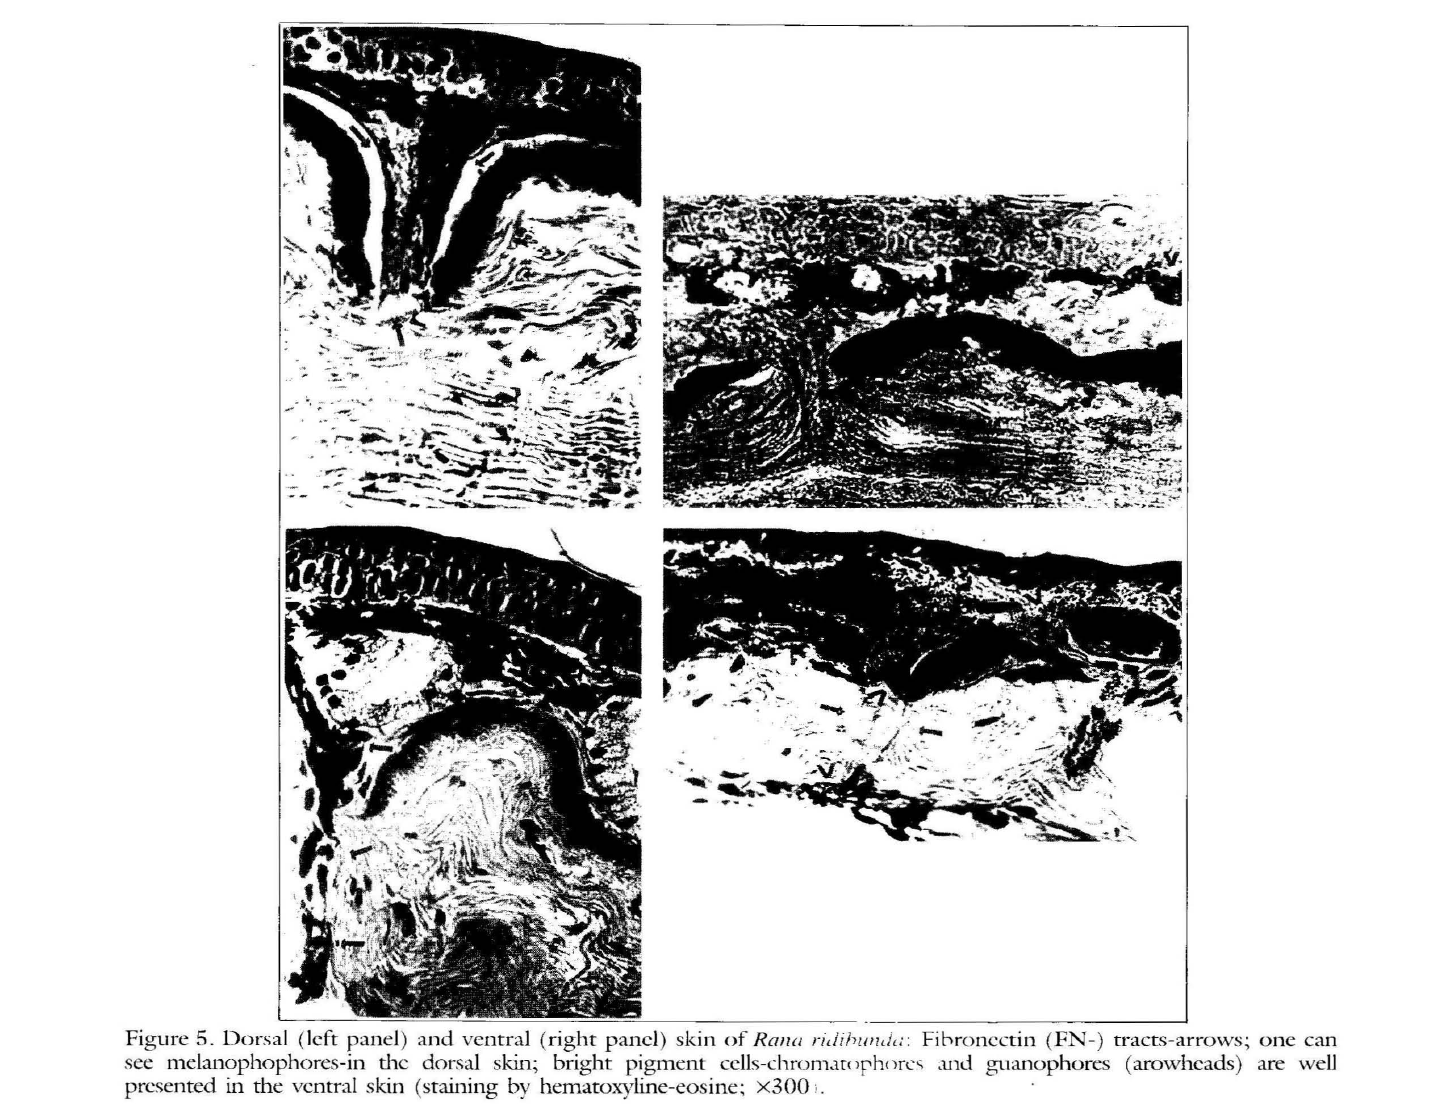
Figure 5. D()I".~al (left panel) and ventral (right panel) skin of Ra/UI ridihlllld'i _ Fibronectin (FN -) tracts-arrows; one can see melanophophores-in the dorsal skin; bright pigment cclls-chrom.u"rhnrcs ,lnd guanophores (arowheads) are well presented in the ventral skin (staining by hematoxyline-eosine; x 300 ;_ Pteridines / Vol. 10 /